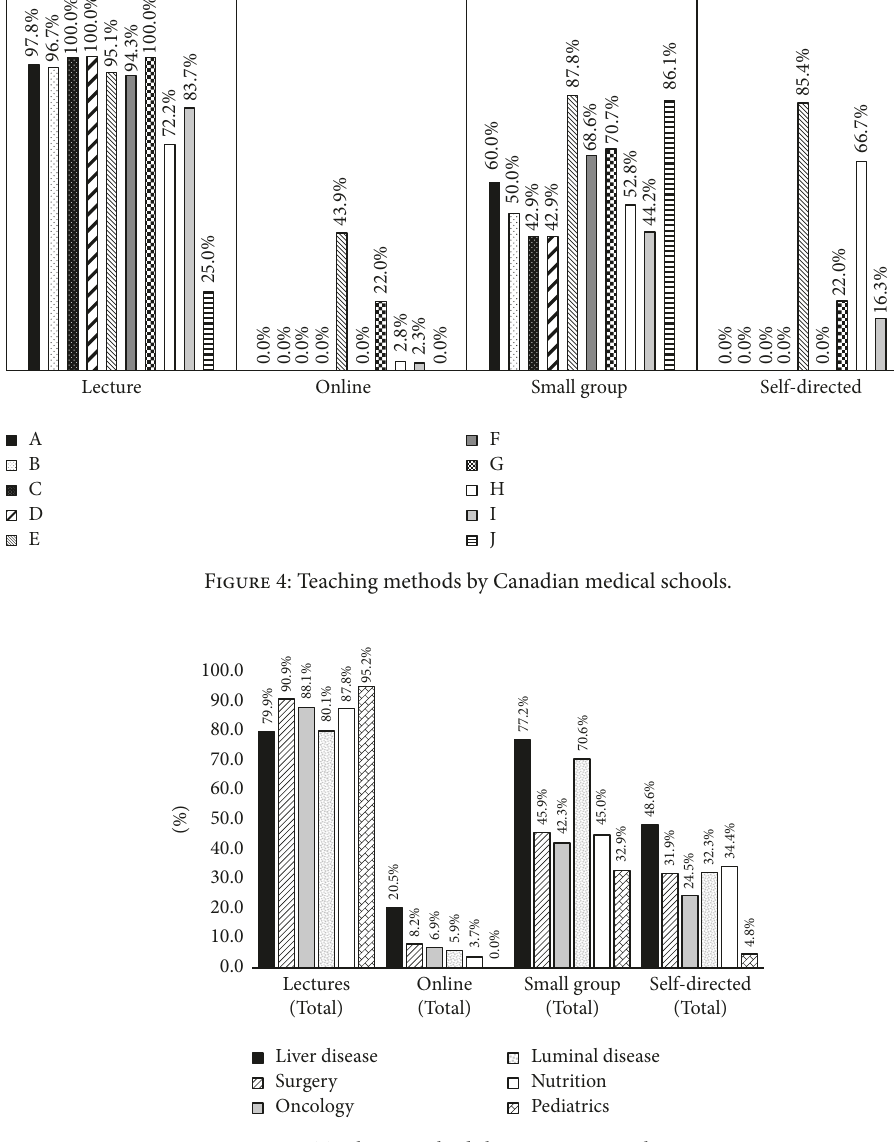
Figure 5: Teaching methods by gastrointestinal